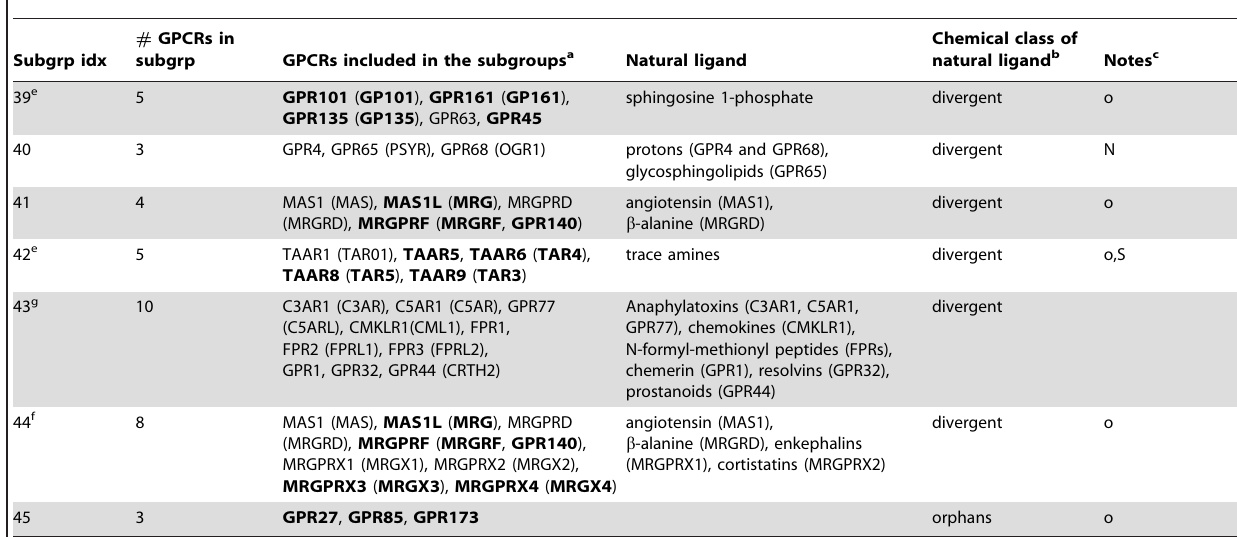
Table 4. List of class A GPCRs included in the study (continued from Tables 1, 2 and 3).